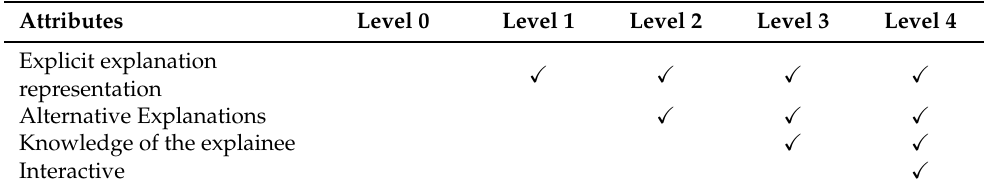
Table 1. Tabular representation of levels of explanation and the corresponding attributes.